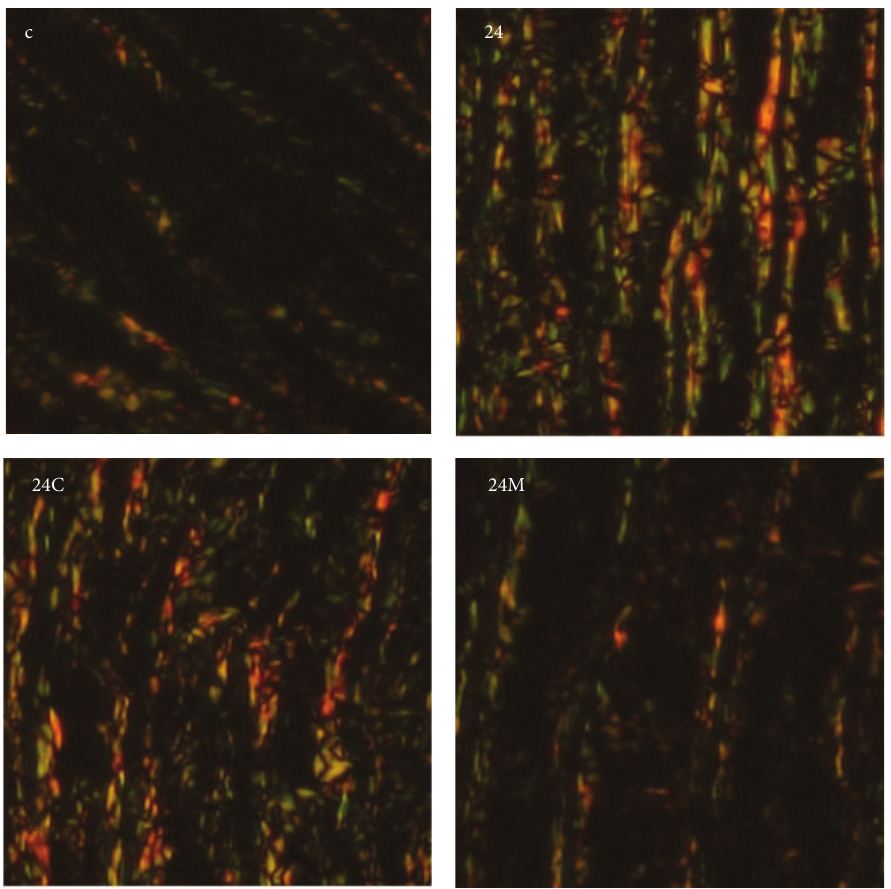
Figure 7: The influence of captopril (24C) and melatonin (24M) on the concentration of collagen in the aortic media in 24 hours/day continuous light exposure-induced hypertension (24). Specimens are stained with picrosirius red and evaluated in polarized light: red to yellow color represents collagen I and green color represents collagen III. c: Wistar controls (according to [36] with